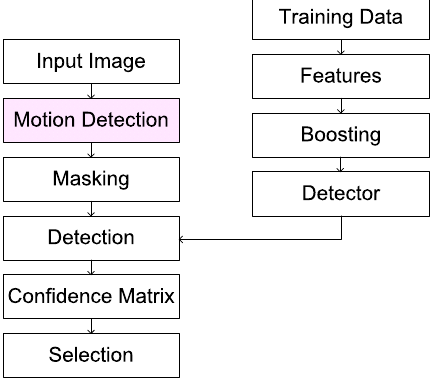
Figure 1: Workflow of proposed car detection